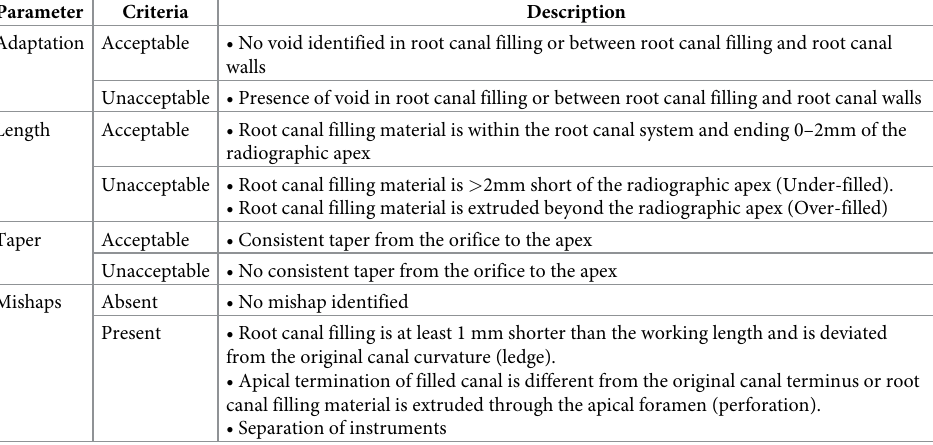
Table 1. Criteria used to assess the quality of root canal obturation. Adopted from Wong CY et al .